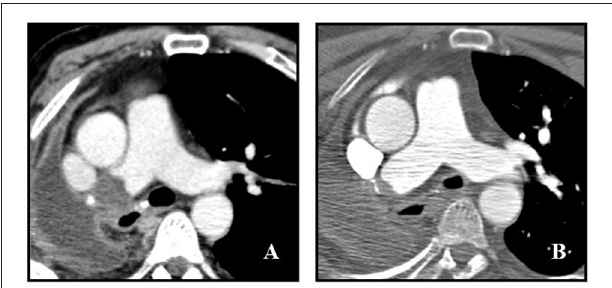
FIGURE 1 | Post-pneumonectomy thrombosis of right pulmonary artery stump. (A) Initial contrast-enhanced CT scan shows a large endoluminal filling defect in the right pulmonary artery stump. (B) Follow up contrast-enhanced CT scan obtained 4 months after (A) shows marked reduction of thrombus size with evidence of a small residual intraluminal defect adjacent to surgical